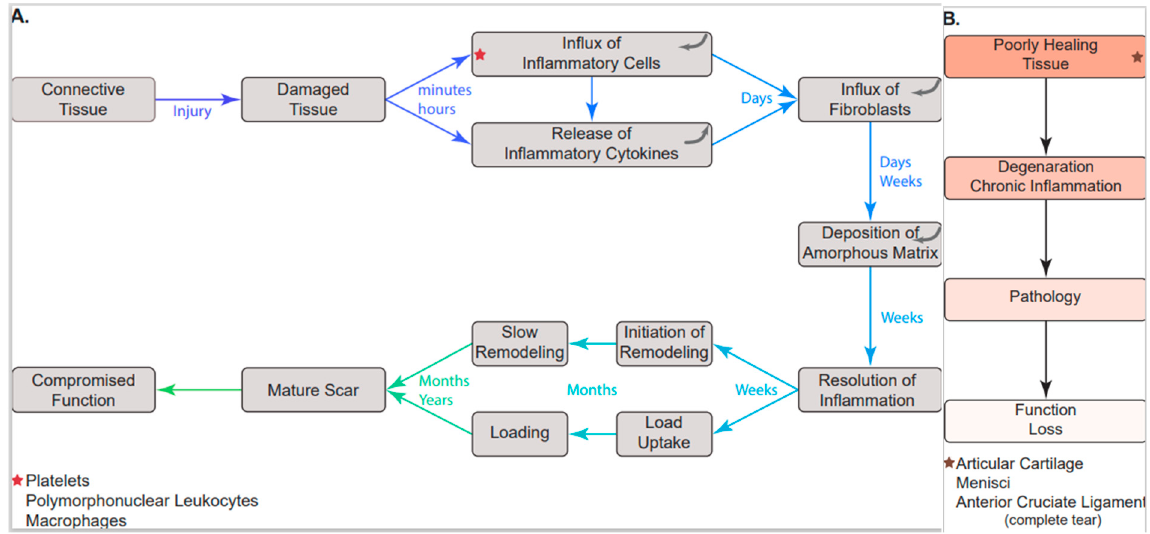
Figure 1. Sequence of events following injury to soft tissues of the MSK system. Following injury to most soft tissues of the MSK system, a sequence of events leading to scar tissue formation and maturation occurs ( A ). This sequence of events involves an inflammatory response that resolves over time as the scar tissue forms and matures. In some tissues, these events do not lead to a healing response and involve an inflammatory response that may become chronic with development of pathology and loss of function ( B ).